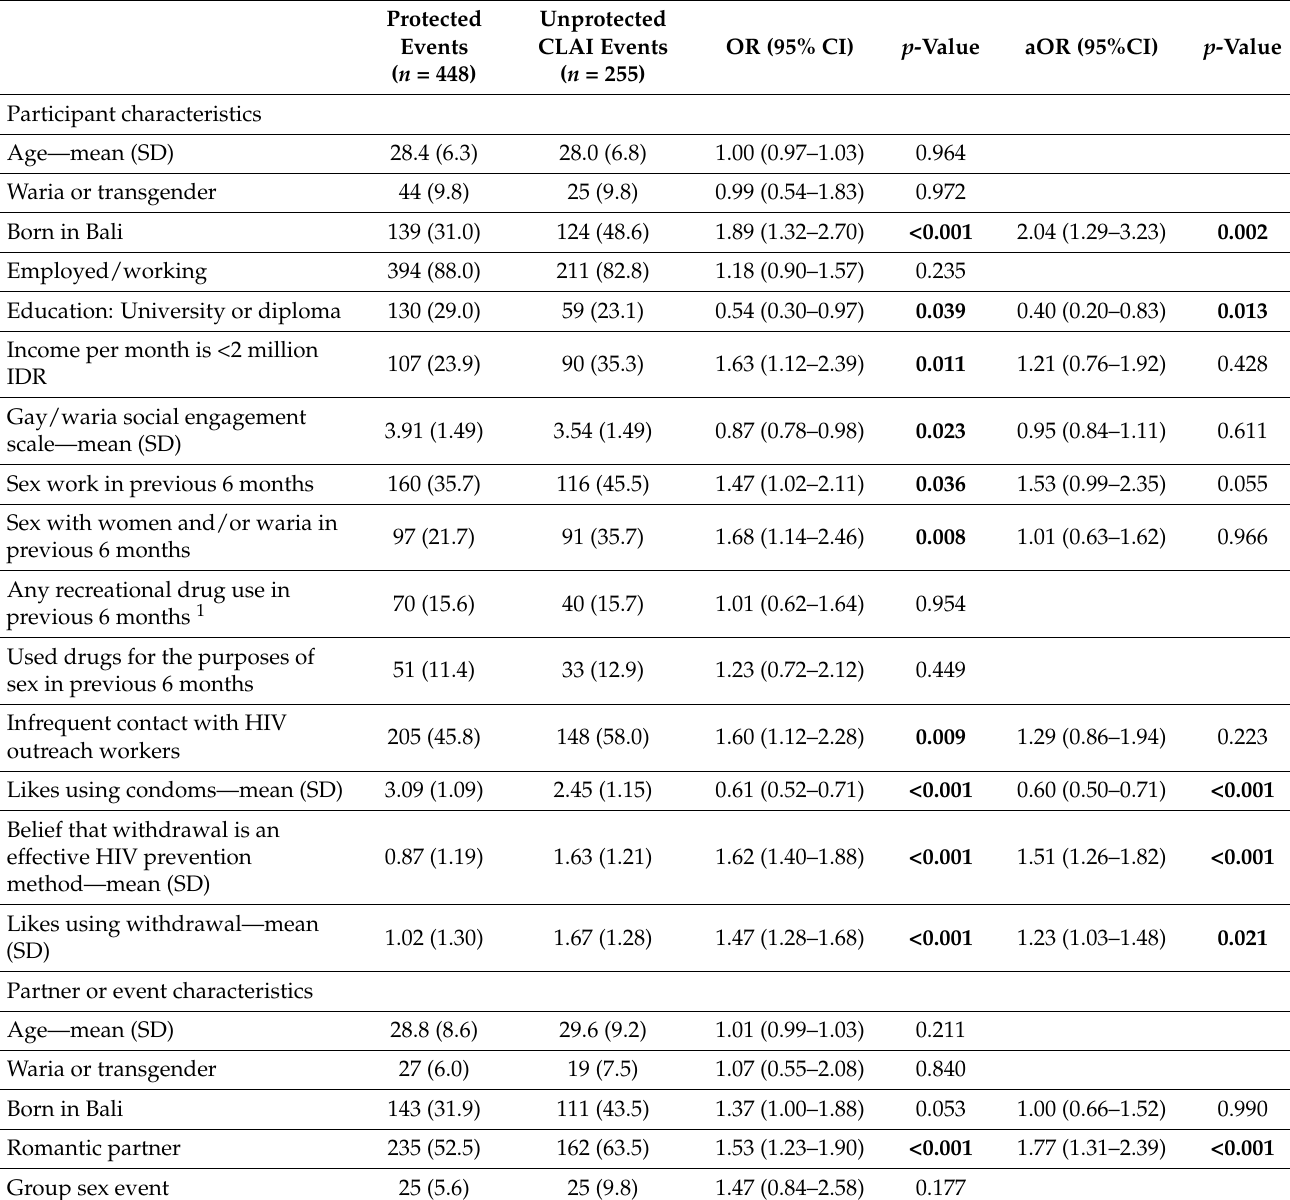
Table 3. Associations with CLAI unprotected by condoms or biomedical HIV prevention (‘unprotected CLAI events’) using generalised estimating equations